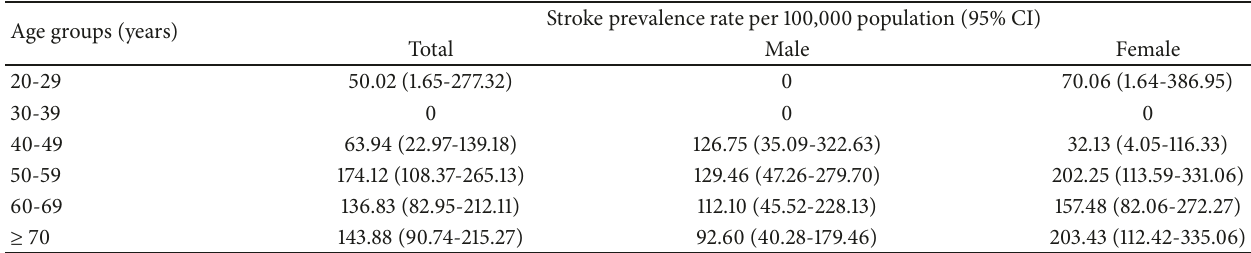
Table 3: Age- and gender-adjusted prevalence rate of stroke ∗